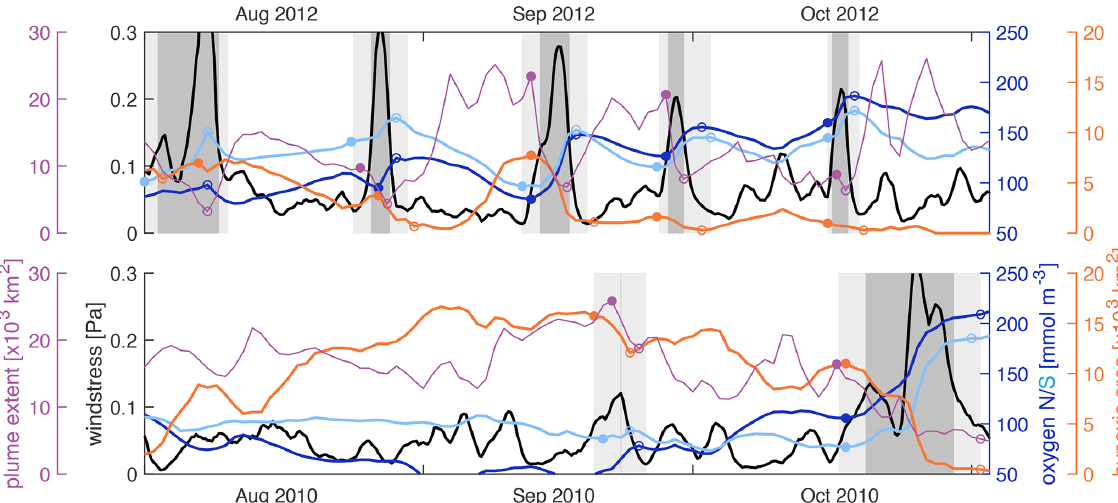
Figure 10. Wind stress (black), mean bottom oxygen in the northern and southern zones (dark and light blue), total hypoxic extent (orange), and FW plume extent (purple) throughout August, September, and October of 2010 and 2012. The filled and open circles indicate a variable’s value at the beginning and after high-wind events. High-wind days (events) are indicated by the dark (light) grey